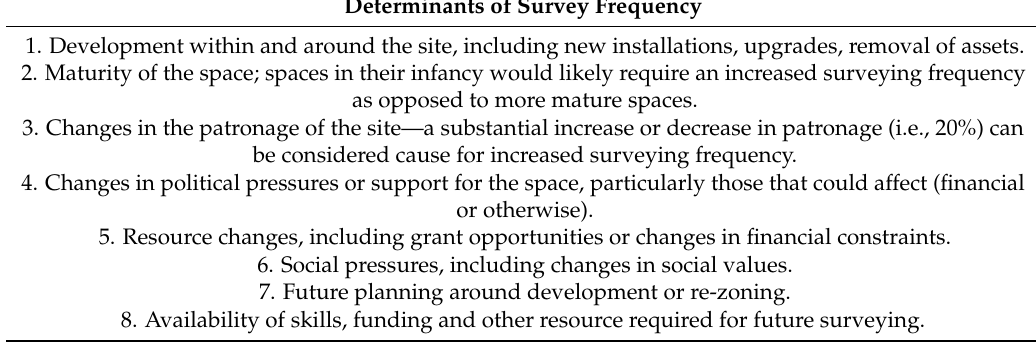
Table 4. Factors to be considered in determining a suitable survey frequency to facilitate evidence based management of urban PGI